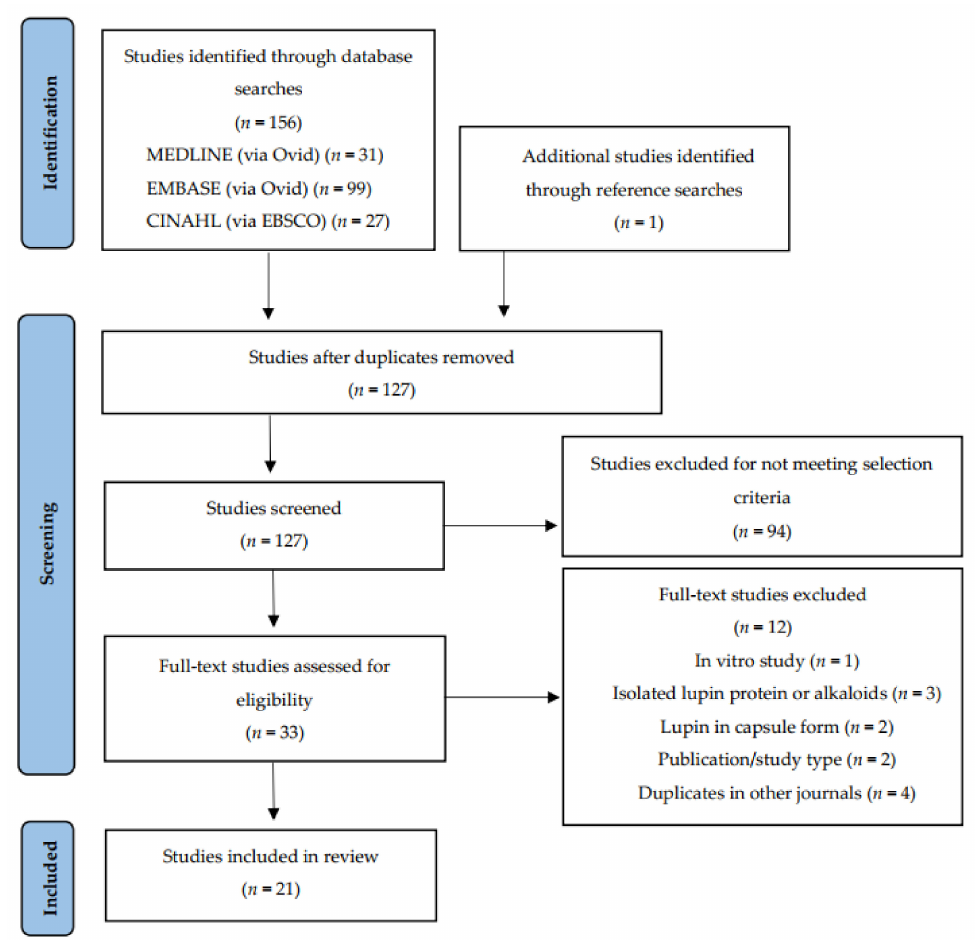
Figure 1. Preferred Reporting Items for Systematic Reviews and Meta-Analyses (PRISMA) flow diagram for study